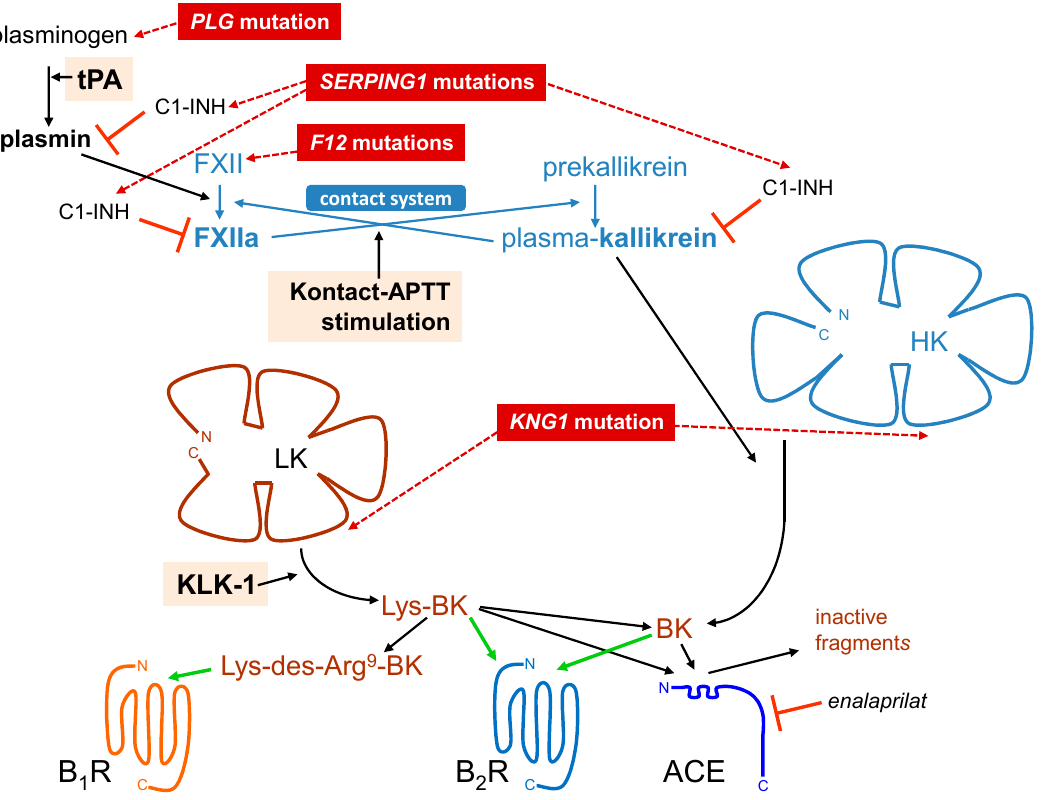
Figure 1. Schematic representation of the kallikrein-kinin system, featuring the 2 validated pathways of kinin generation, that of plasma kallikrein (part of the contact system) releasing bradykinin (BK) from high molecular weight kininogen (HK) and that mediated by secreted tissue kallikrein (KLK-1), generating Lys-BK mainly from low molecular weight kininogen (LK). Some of the known mutant genes that cause HAE-nC1-INH (dark red background with dotted arrows pointing to the corresponding mutant proteins) and the standardized stimuli applied in vitro to trigger kinin formation (pale orange background) are also indicated. Elements of the contact system are represented in light blue. Black and blue arrows represent biochemical reactions. Green arrows indicate an agonist effect on a receptor. “ ⊥ ” Inhibition of a protease or peptidase. See Table 1 for abbreviations.